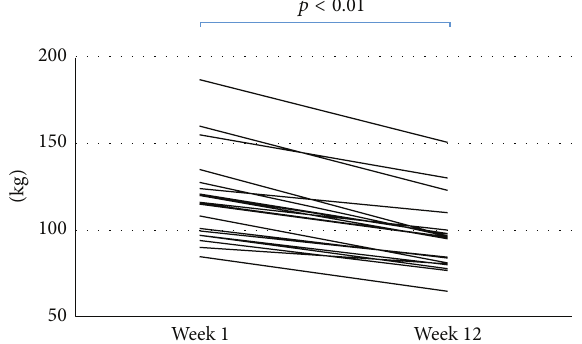
Figure 2: Individual weight loss after 12 weeks on diet.